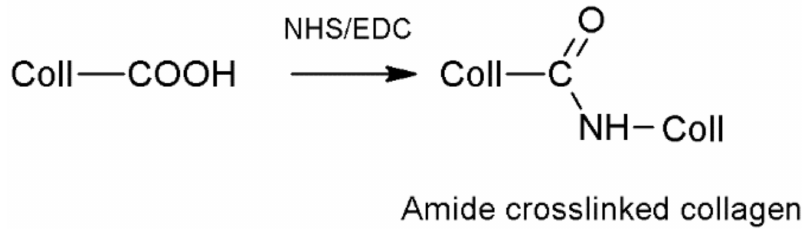
Figure 8. Chemical cross-linking reaction of collagen using EDC/NHS [113,140]. Nong et al. [141] described the preparation of collagen scaffolds cross-linked with the 1- ethyl-3-(3-dimethylaminopropyl) carbodiimide and N -hydroxysuccinimide in 0.033